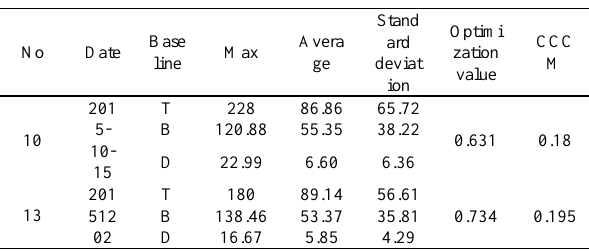
Figure. 2 Experimental area results curve